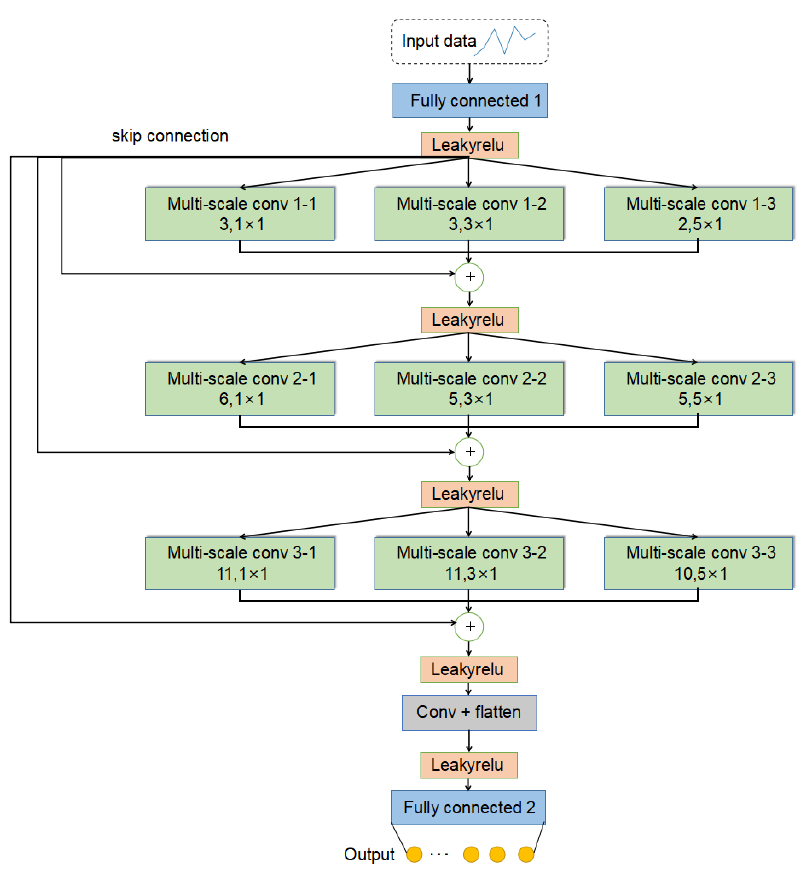
Figure 6. The framework of MCNN ( “ + ” represents “ concat ” operation).